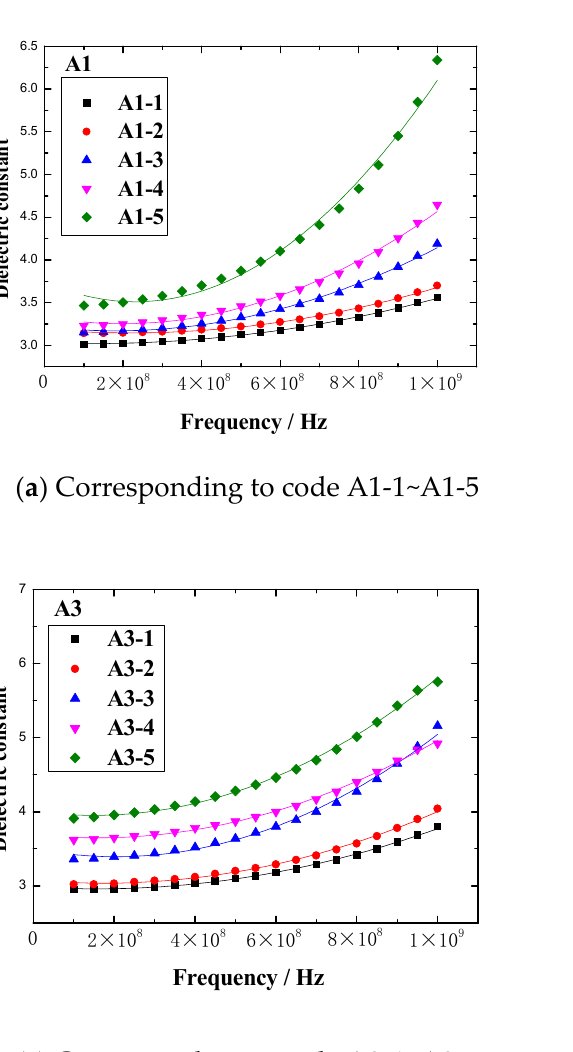
Figure 13. The dielectric constant vs. frequency plots of the rubber samples in the frequency range of 0.1–1 CHz.